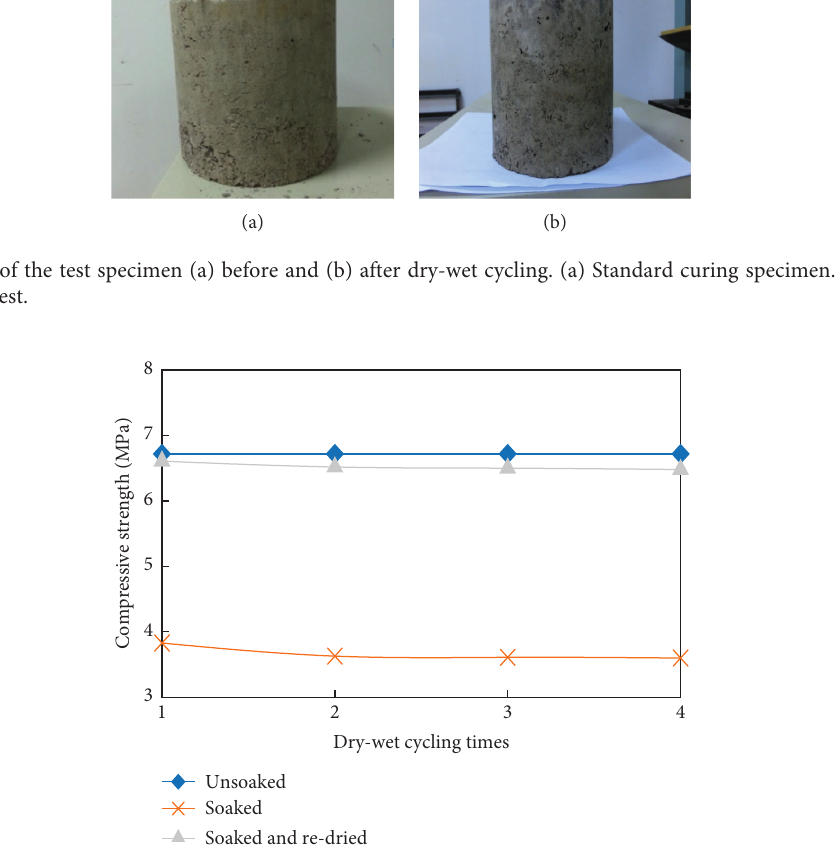
Figure 18: Compressive strength change law of different dry-wet